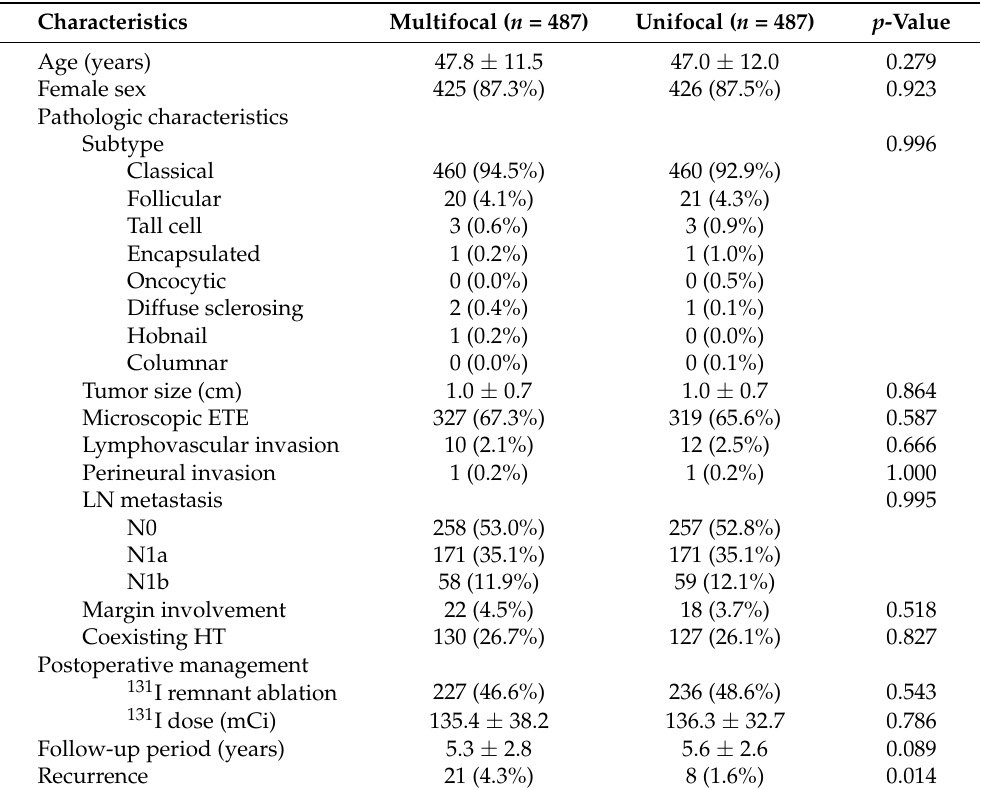
Table 2. Comparison of clinicopathological characteristics between patients with multifocal PTCs and those with unifocal tumor after propensity score matching.